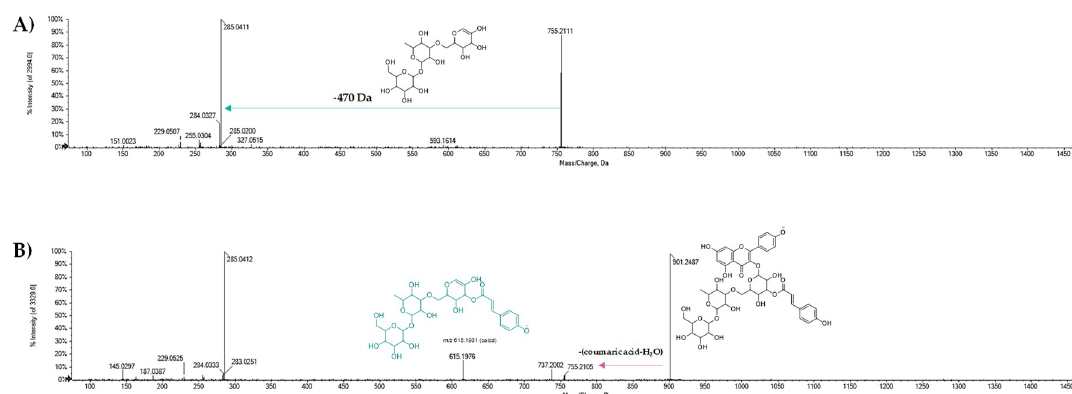
Figure 6. TOF-MS / MS spectra of [M − H] − ion of some of kaempferol triglycosides ( A ) 29 and ( B ) 41 . In the B panel, the presence of a coumaroyltryglycosyl moiety was highlighted by detecting the ion at m / z 615.1976.